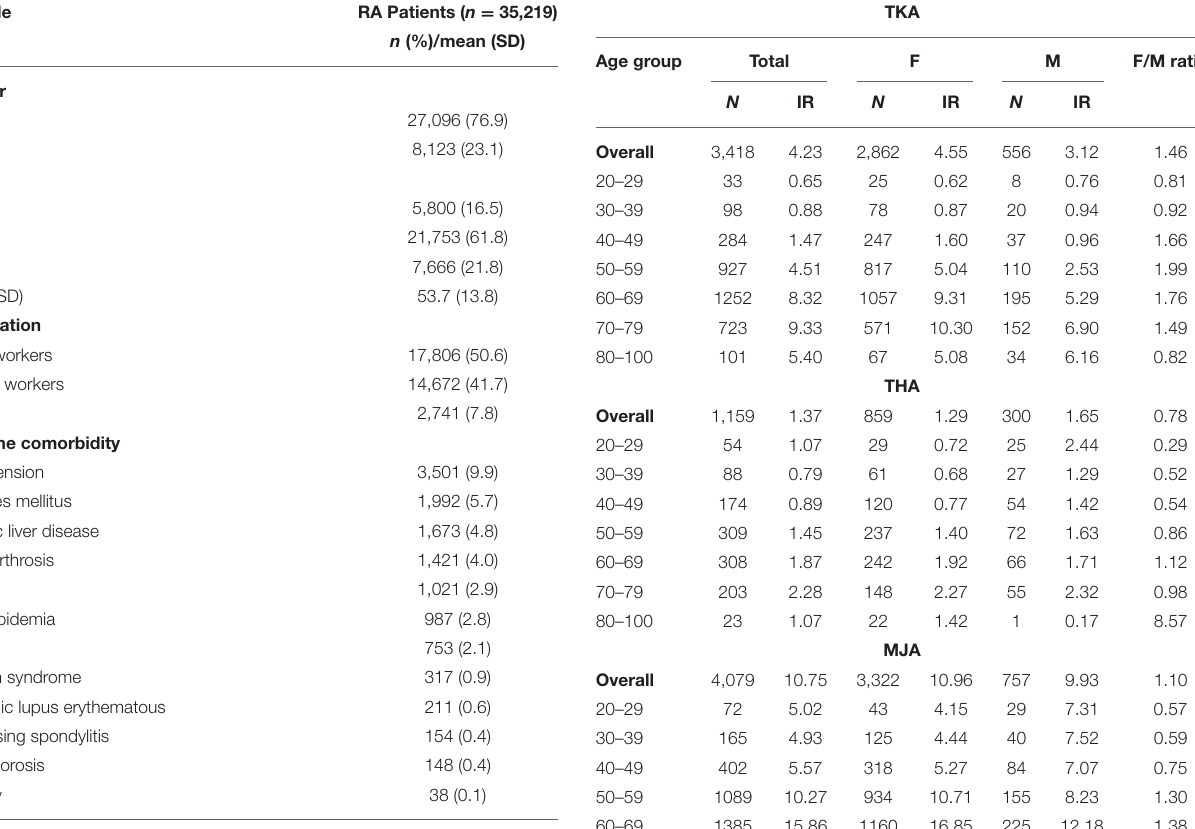
TABLE 2 | Incidence rate and number of cases stratified by gender and age groups among rheumatoid arthritis (RA) patients from 2000 to 2013.